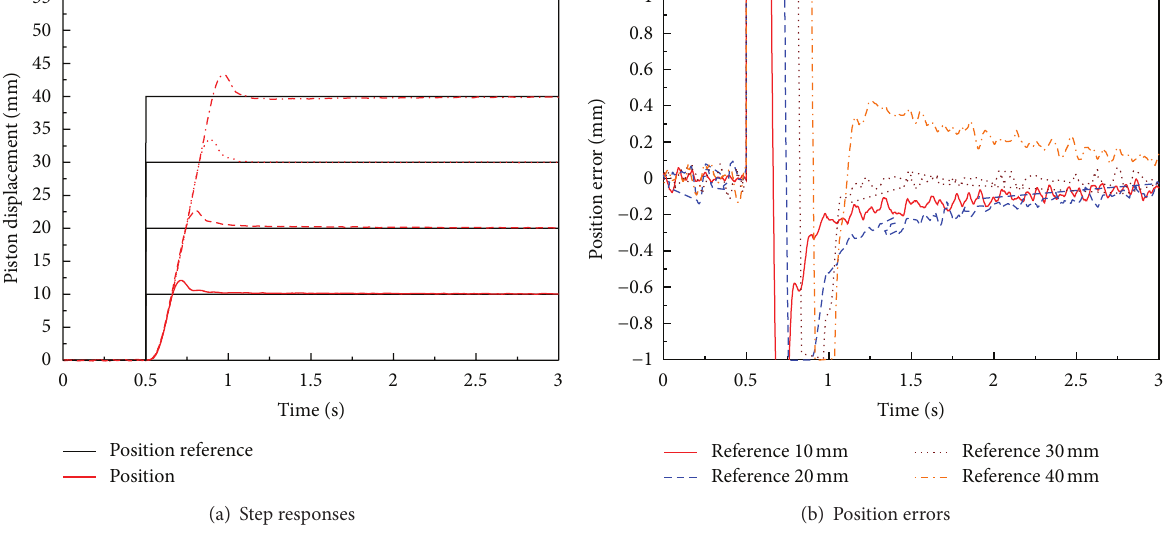
Figure 13: Performances of optimal antiwindup PID position control system for EHA without load disturbance (only mass load is